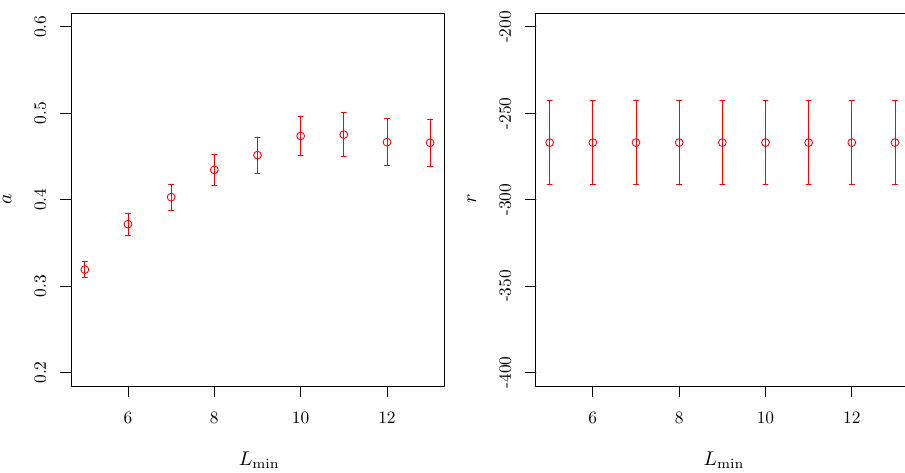
Fig. 9 a and r as functions of L min from the fits of Eq. (21) to the data for (cid:7) E 3 . Both a and r were included in the fit with priors from the fit to (cid:7) E 2 (the values can be found in Table 1)